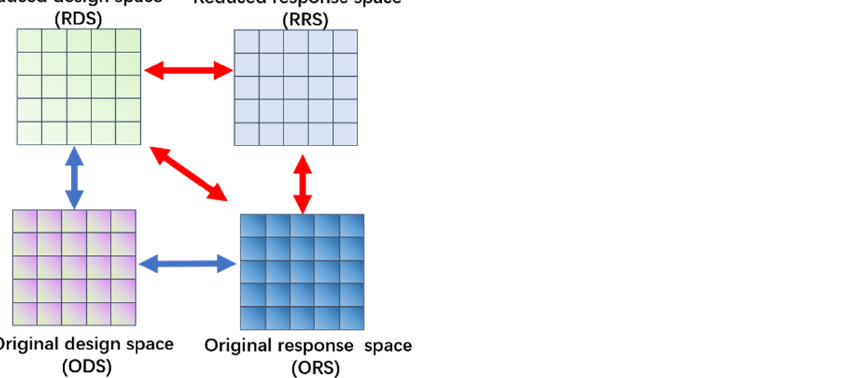
Figure 3. The relationship between different spaces. The red line represents one-to-one mapping and the blue line represents many-to-one mapping.